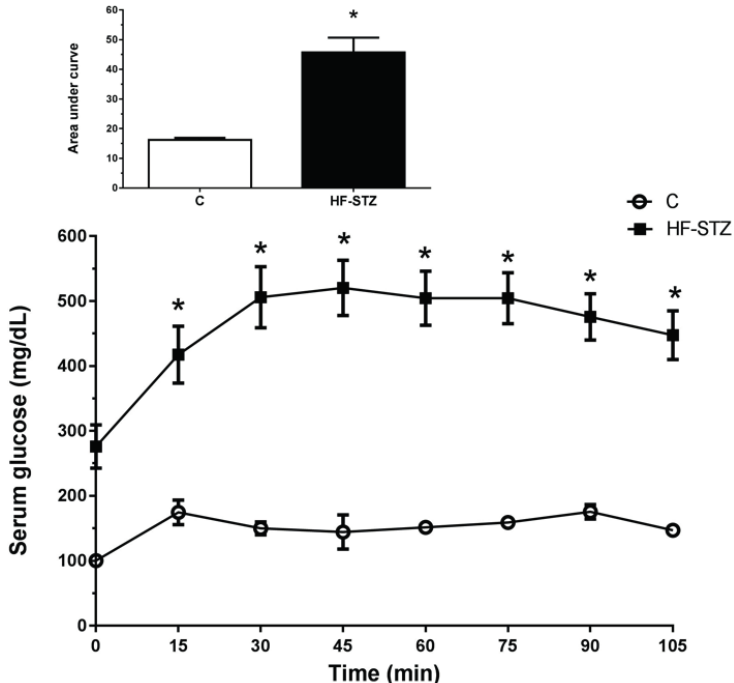
Figure 4 - Serum glucose (mg/dl) and area under curve of the oral glucose tolerance test (OgTT) of male rats subjected to control diet (C) and high-fat diet/ streptozotocin (HF-STZ) for 39 days. Results are expressed as mean ± standard error across six control animals and ten HF-STZ animals in each analysis. * Statistical difference versus C group. Student’s t-test (P